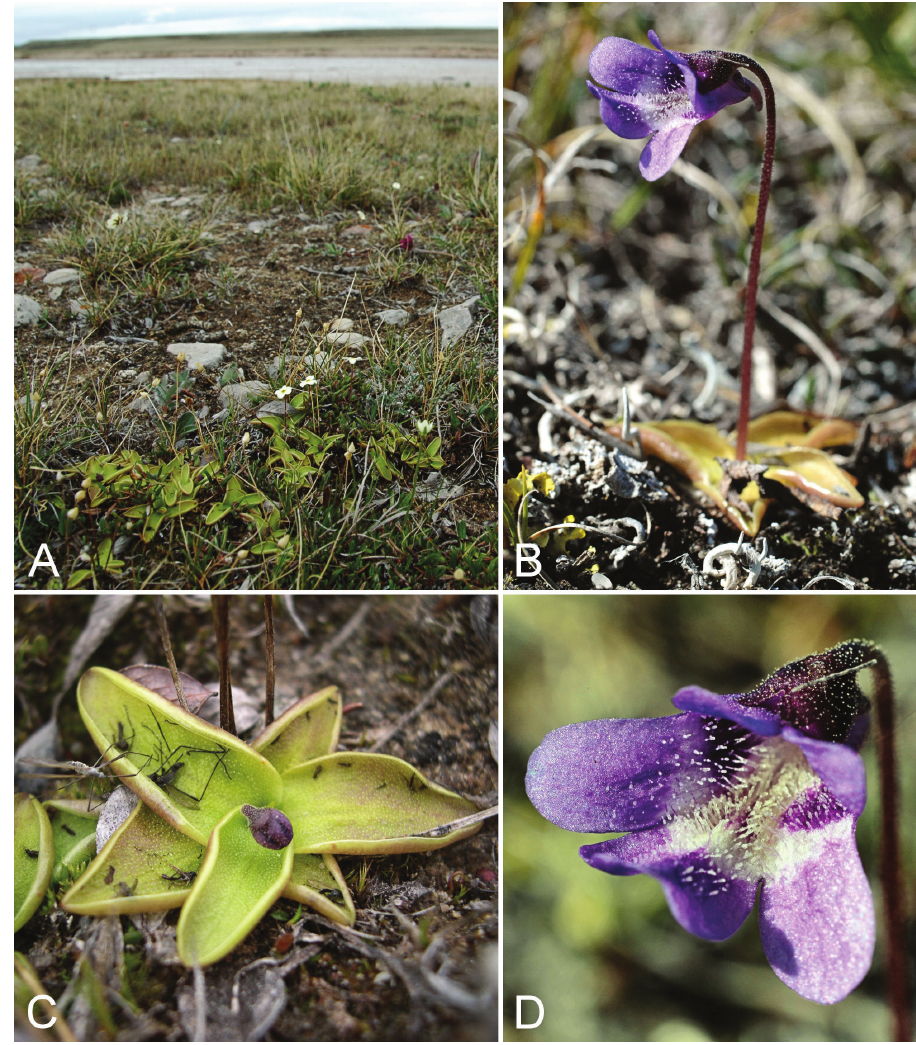
Figure 15. Pinguicula vulgaris : A habitat, Gillespie et al. 7718 B habit, Gillespie et al. 8983b C leaves, Gillespie et al. 7718 D flower, Gillespie et al. 8983b . Photographs by R.D.